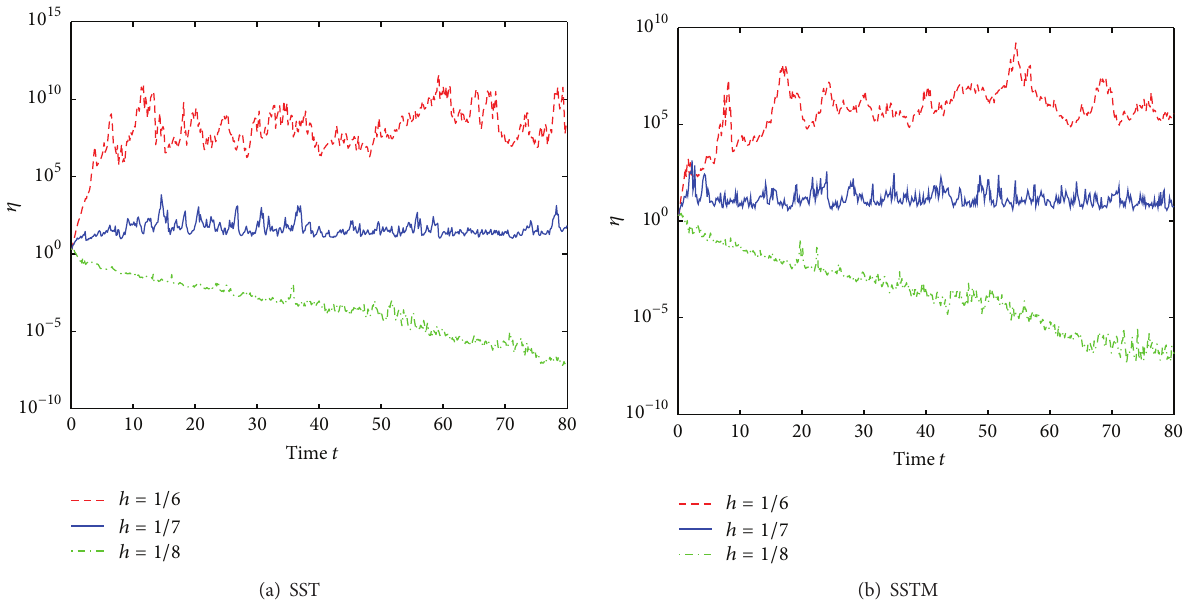
Figure 4: Mean-square stability comparison of SST and SSTM for the SDHNNs (43), Case 1, 𝜃 = 0.2 .